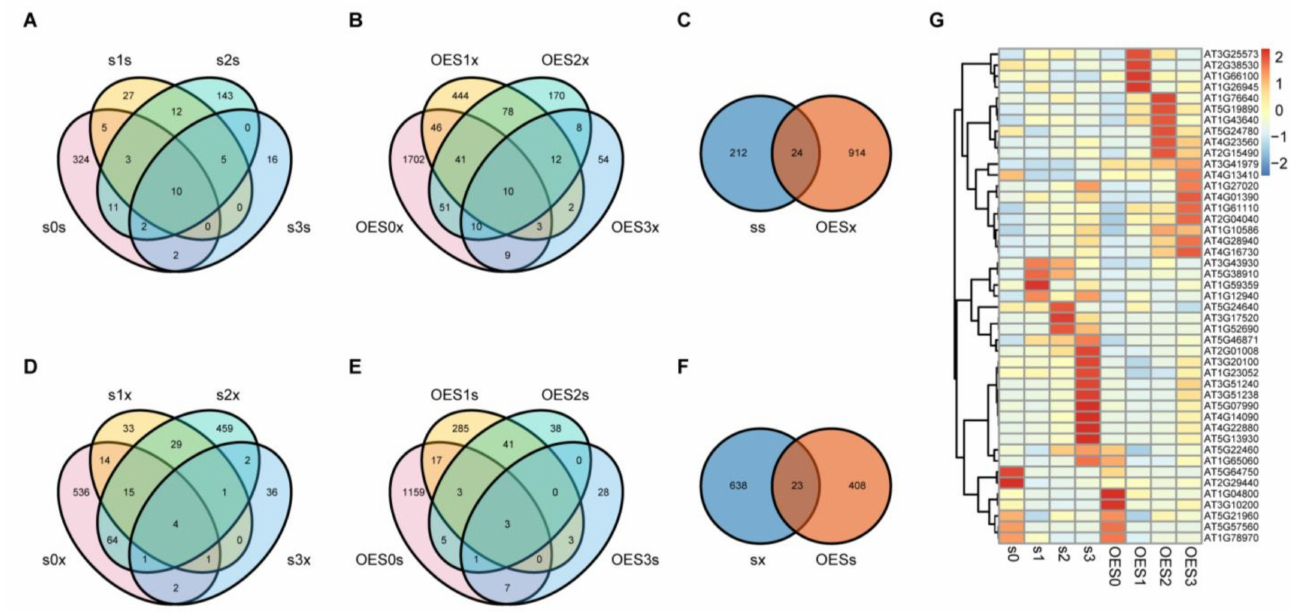
Figure 3. Venn and heatmap analyses of differentially expressed genes (DEGs). ( A ) Venn analysis of DEGs that were up-regulated in sad2-5 compared with Col-0 at 0 days post-inoculation (dpi) (s0s), 1 dpi (s1s), 2 dpi (s2s), and 3 dpi (s3s) with Pseudomonas syringae pv. tomato ( Pst ) DC3000. ( B ) Venn analysis of DEGs that were down-regulated in the SAD2-overexpression line (OESAD2/Col- 0) compared with Col-0 at 0 dpi (OES0x), 1 dpi (OES1x), 2 dpi (OES2x), and 3 dpi (OES3x). ( C ) Venn analysis of overlapping DEGs, i.e., those that were up-regulated in sad2-5 (ss) and down-regulated in OESAD2/Col-0 (OESx). ( D ) Venn analysis of DEGs that were down-regulated in sad2-5 compared to Col-0 at 0 dpi (s0x), 1 dpi (s1x), 2 dpi (s2x), and 3 dpi (s3x). ( E ) Venn analysis of DEGs that were up-regulated in OESAD2/Col-0 compared to Col-0 at 0 dpi (OES0s), 1 dpi (OES1s), 2 dpi (OES2s), and 3 dpi (OES3s). ( F ) Venn analysis of overlapping DEGs, i.e., those that were down-regulated in sad2-5 (sx) and up-regulated in OESAD2/Col-0 (OESs). ( G ) Heatmap analysis of expression profiles of the 45 overlapping DEGs. “s” here indicates sad2-5 ; “OES” indicates OESAD2/Col-0; and numbers following “s” or “OES” indicate dpi with Pst